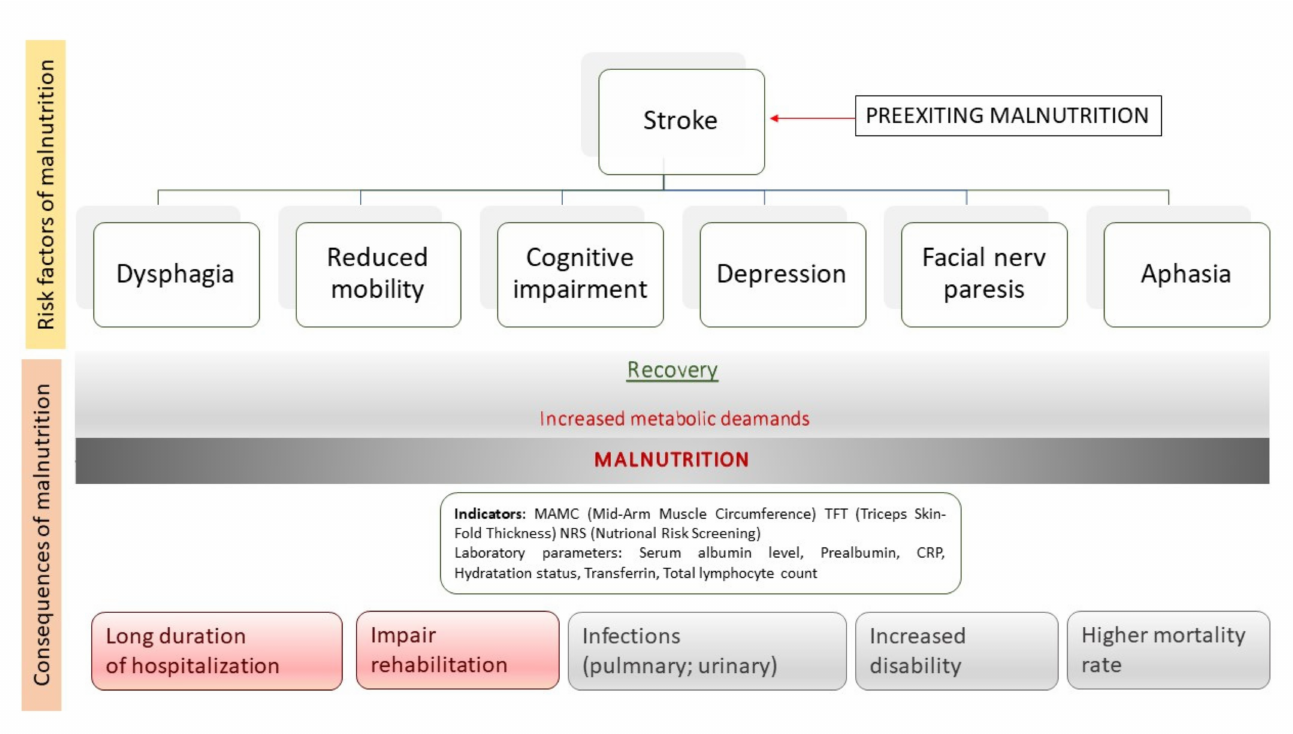
Figure 1. Risk factors and consequences of post-stroke patient’s